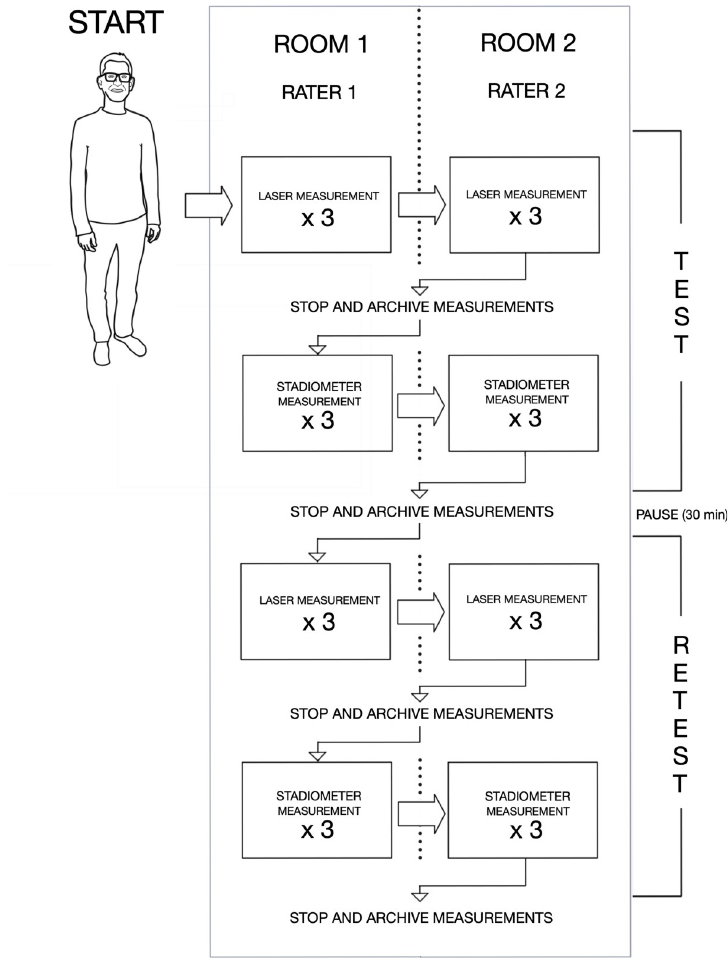
Fig 3. Overview of the measuring